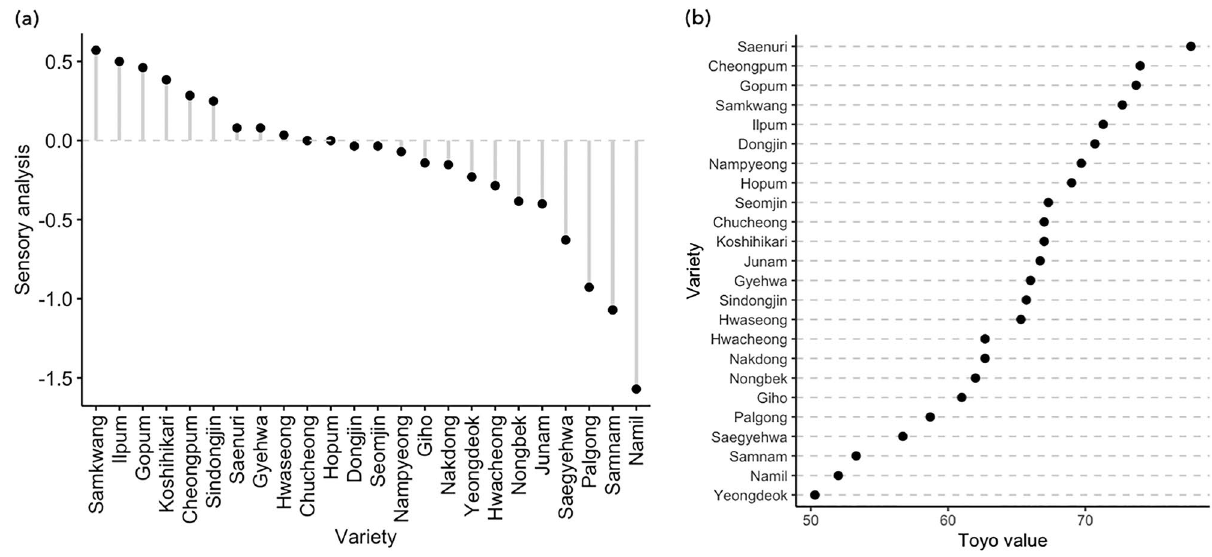
Figure 1. Evaluation of the EQ of 24 rice cultivars using the sensory panel test and Toyo taste-meter. ( a , b ) EQ of rice cultivars measured by the sensory panel test ( a ) and Toyo taste-meter ( b